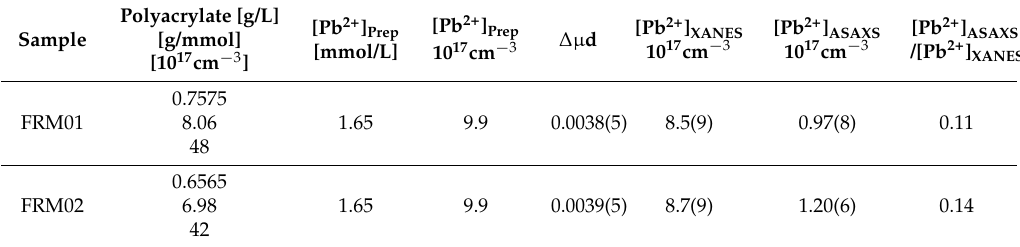
Table 1. The concentrations of polyacrylate monomers and of Pbcounterions of the samples investigated in the present study: [Pb 2+ ] Prep known from preparation, [Pb 2+ ] XANES deduced from XANES measurements, and [Pb 2+ ] ASAXS deduced from RI-analysis. ∆ µ d was taken from XANES measurements (see below).